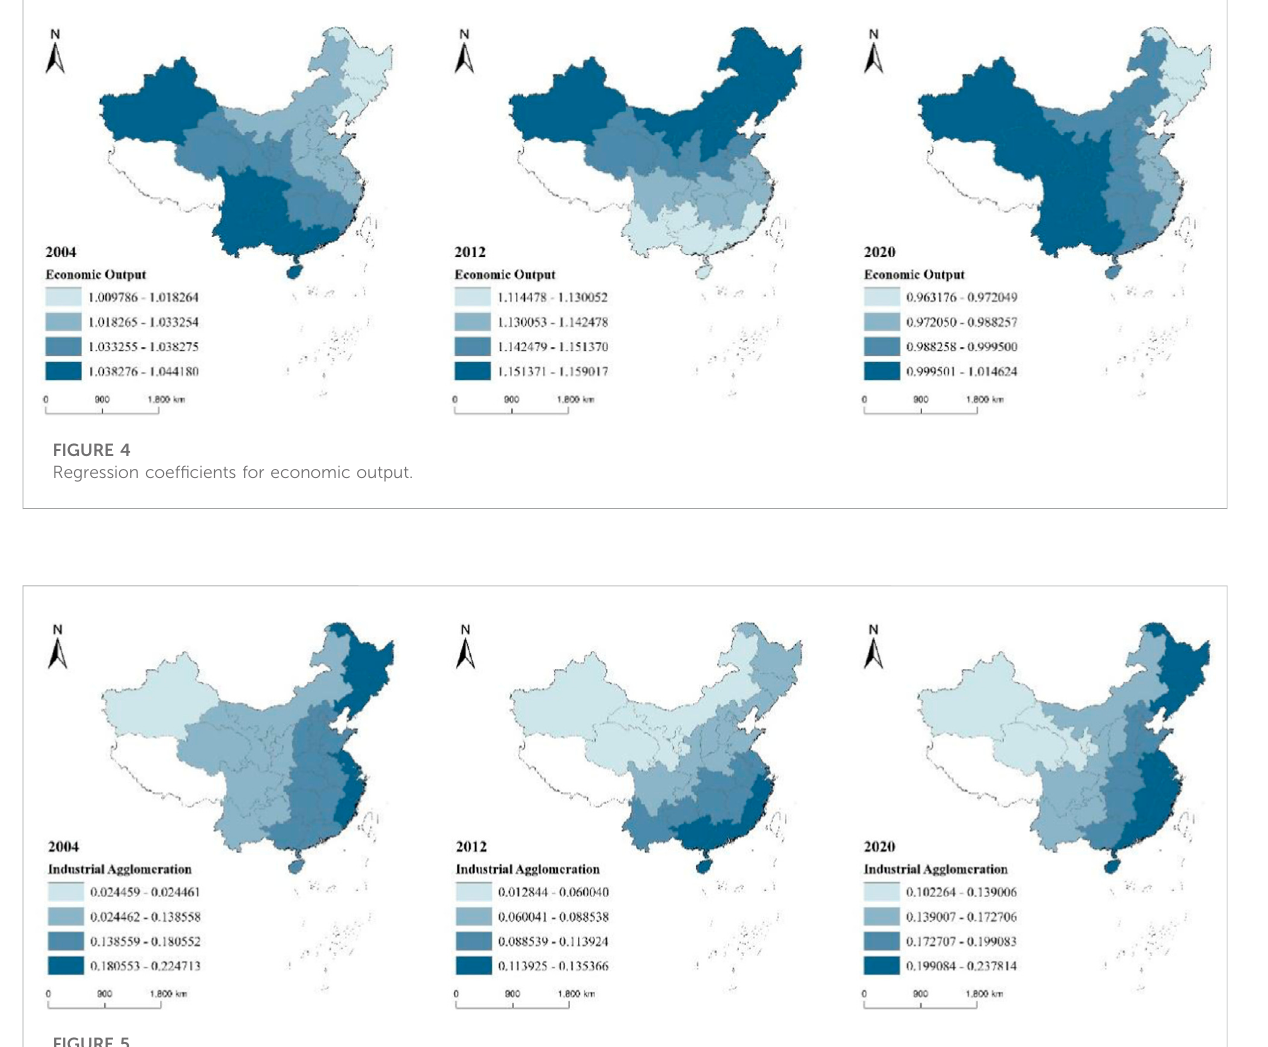
FIGURE 5 Regression coef fi cients for industrial